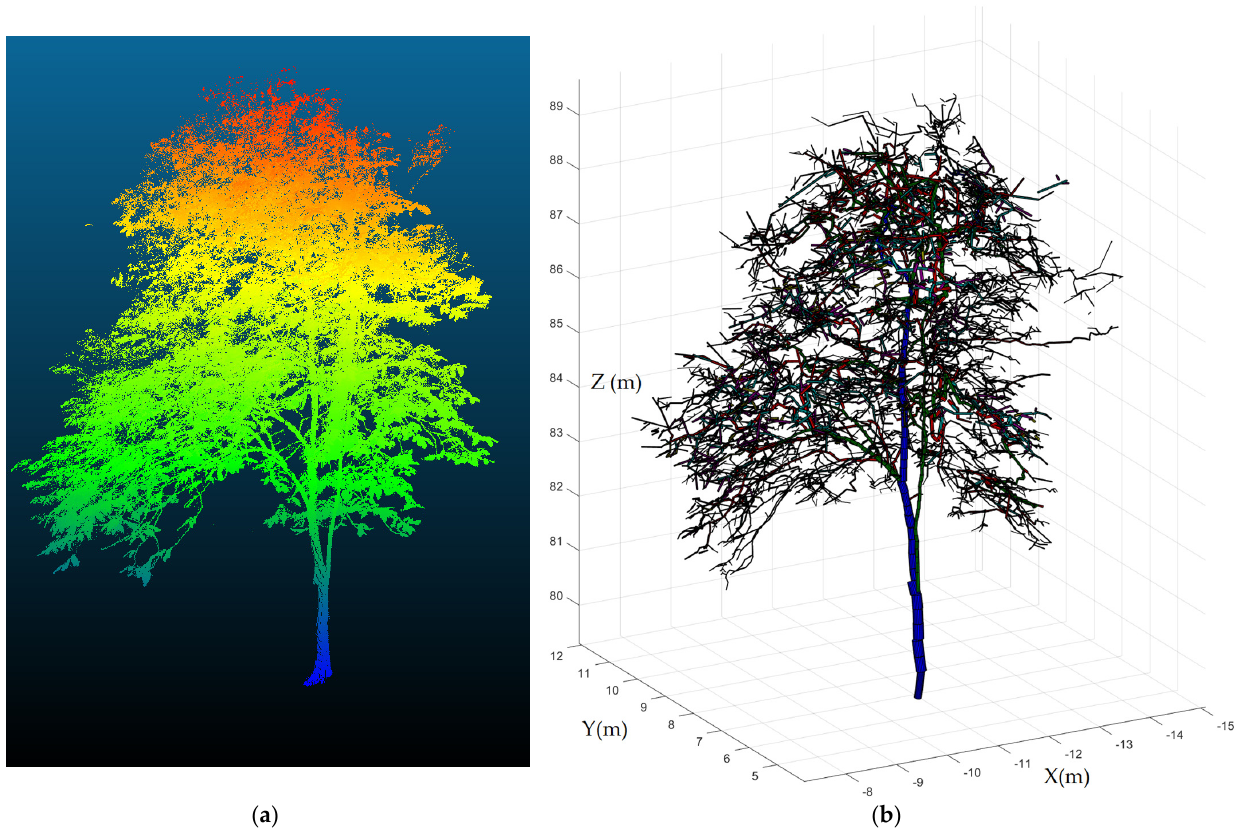
Figure 7. (a) TLS point cloud coloured by height (lowest values in blue and highest values in red). (b) Resulting QSM model from the algorithm by Raumonen et al. [177]. Data Source: (Madhibha, 2016) [178].